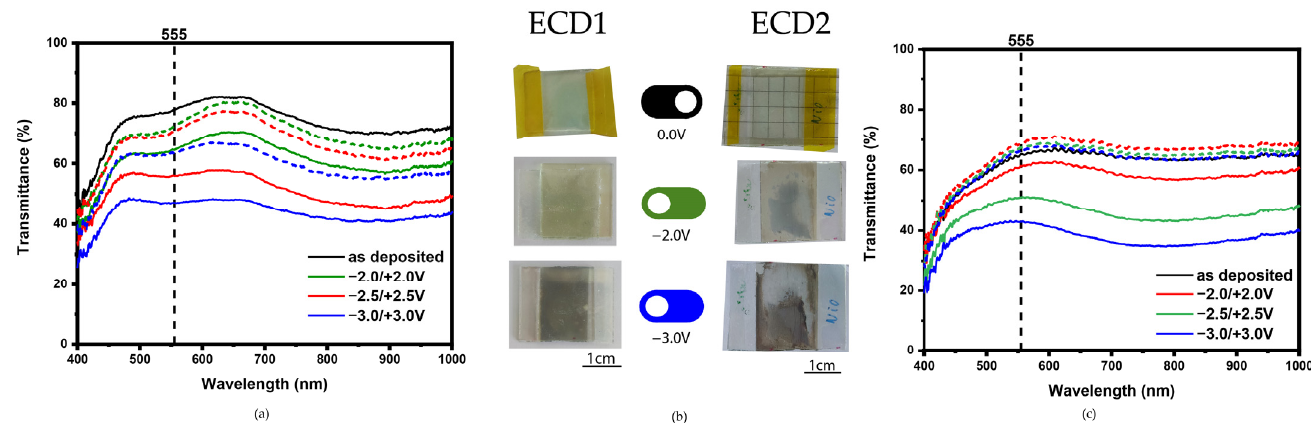
Figure 5. Transmission spectra in the 400–1000 nm regions of the ECD1 ( a ) and ECD2 ( c ) devices. Representative images of the ECDs ( b ) colored states [semi-bright mode ( − 2.0 V, green solid line)], dark mode ( − 3.0 V, blue solid line) and the bleached state [corresponding dotted lines, bright mode]. Table 1. Parameters for ECDs characterization.